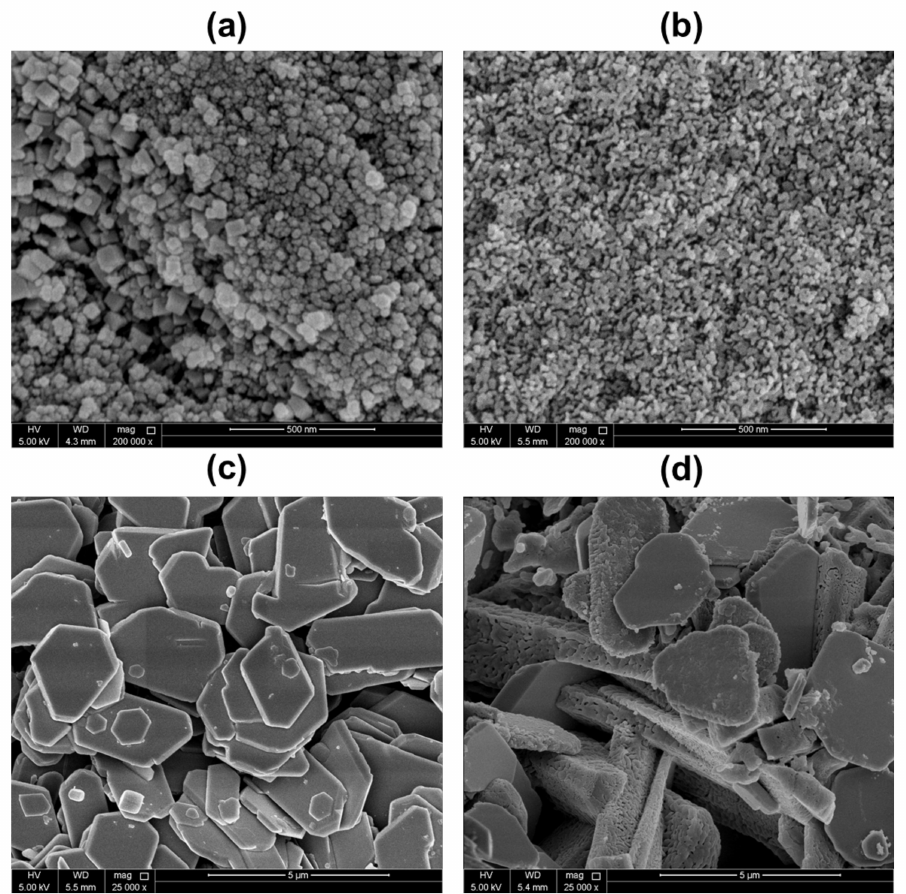
Figure 1. SEM images of CeO 2 ( a , b ) and Yb 2 O 3 ( c , d ) synthesized by hydrothermal method followed by annealing in absence ( a , c ) and in presence ( b , d ) of Triton TM X-100 as a surfactant.